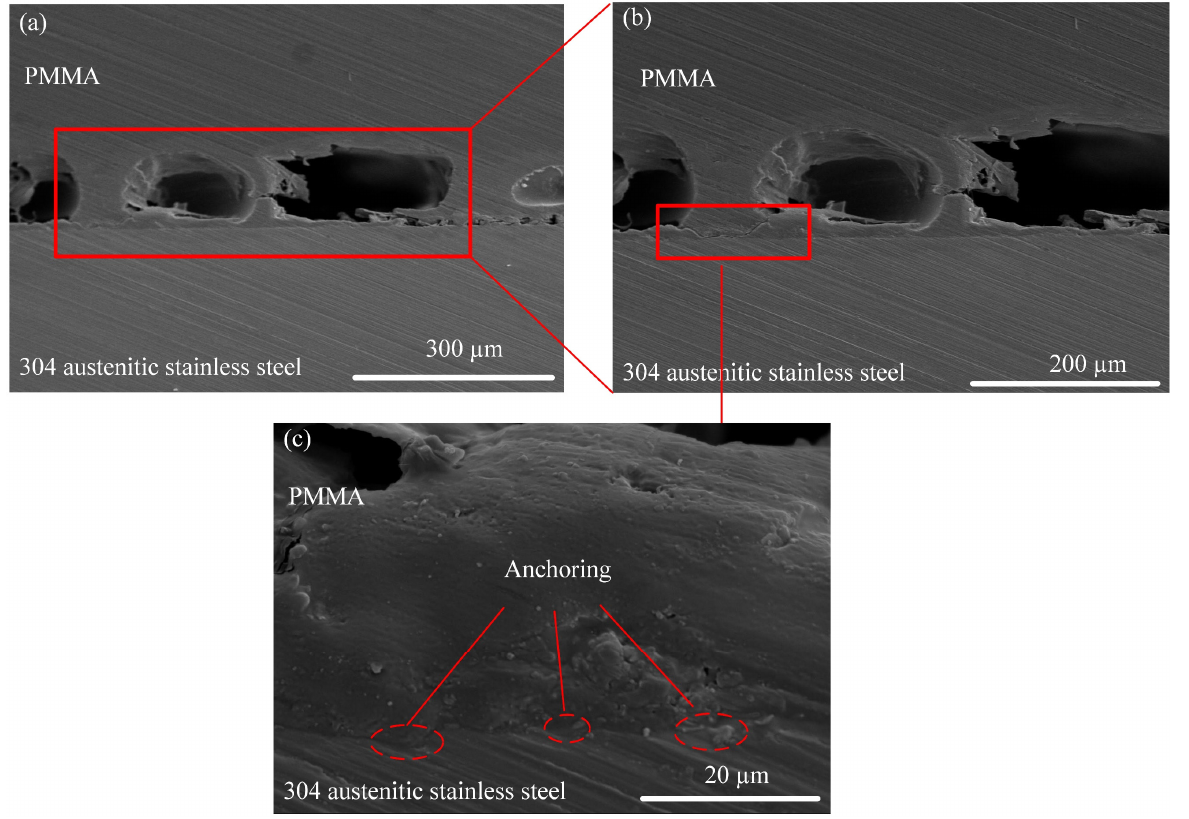
Figure 9. ( a ) Cross-sectional SEM image of the joint interface for the NO.5 joint, ( b ) an enlarged view of the boxed region in ( a ) and ( c ) an enlarged view of the boxed region in ( b ).